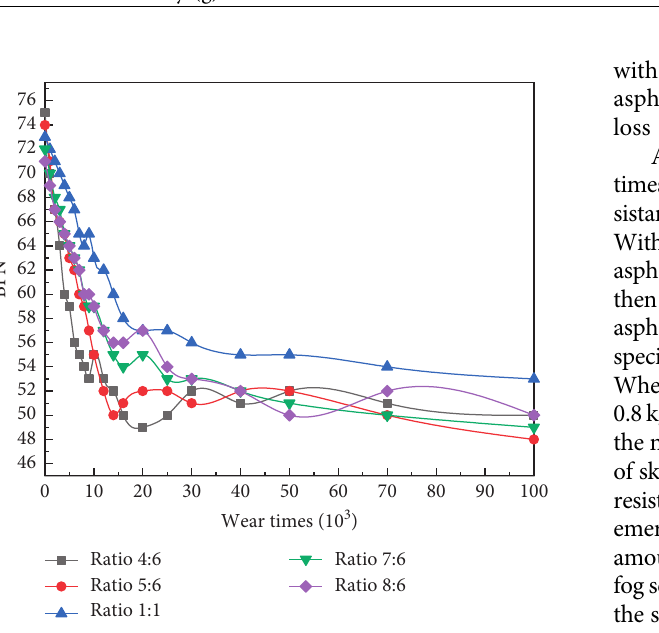
Figure 15: BPN abrasion law of specimens.